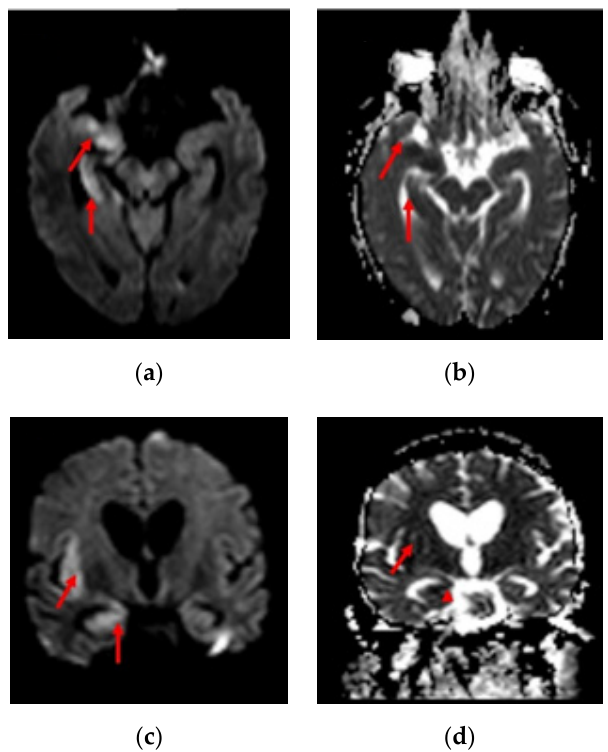
Figure 3. 54-year-old man with COVID-19 RT-PCR positive and history of fever, cough for 7 days with recent onset headache and vomiting. MRI DWI ( a ) and ADC ( b ) showed di ff usion restriction with corresponding hypointensity on ADC (red arrow) in the medial aspect of right anterior temporal lobe, hippocampus and sylvian cortex. MRI DWI ( c ) and ADC ( d ) showed di ff usion restriction with corresponding hypointensity on ADC (red arrow) in the medial aspect of right anterior temporal lobe, hippocampus and sylvian cortex.